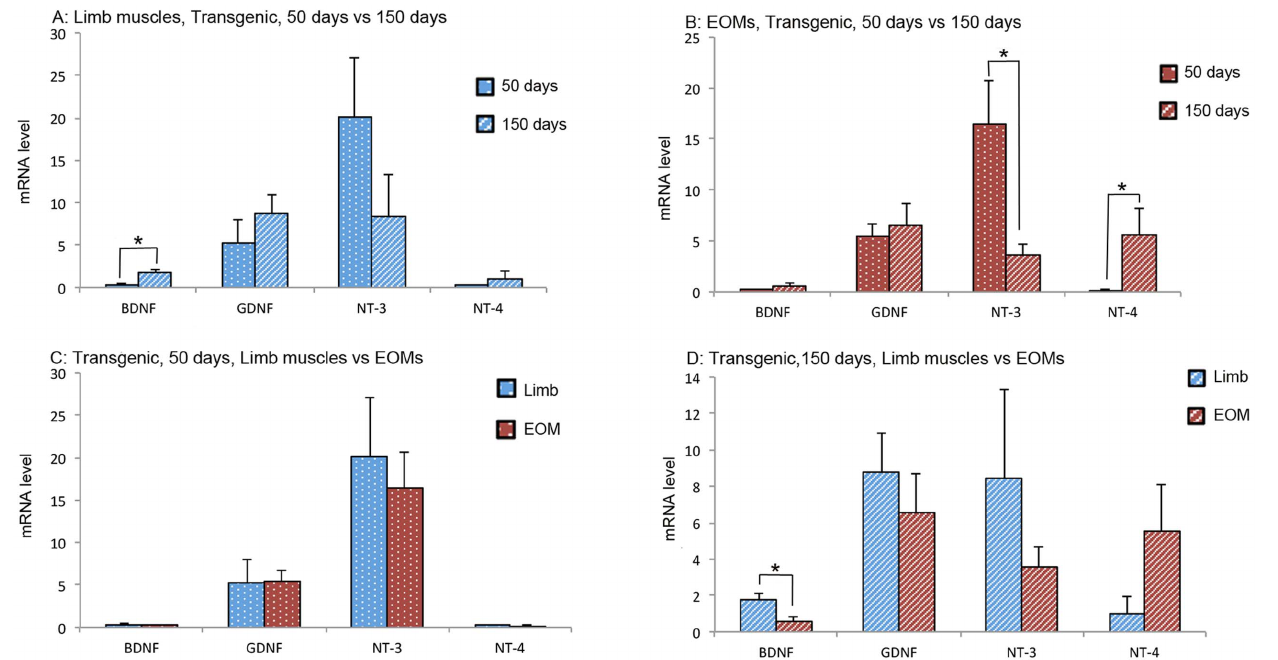
Figure 3. mRNA levels of NTFs in limb muscles and EOMs from early and late stage ALS mice. Top panels: comparison of NTF expression in limb muscles (A) and EOMs (B) between early and late stages. Bottom panels: comparison of NTF expression between limb muscles and EOMs of early (C) and late stages (D). The expression levels are given using arbitrary units normalized by b -actin expression. Bars represent mean 6 SD from analysis of at least 5 separate samples run in triplicate. *: p , 0.05.